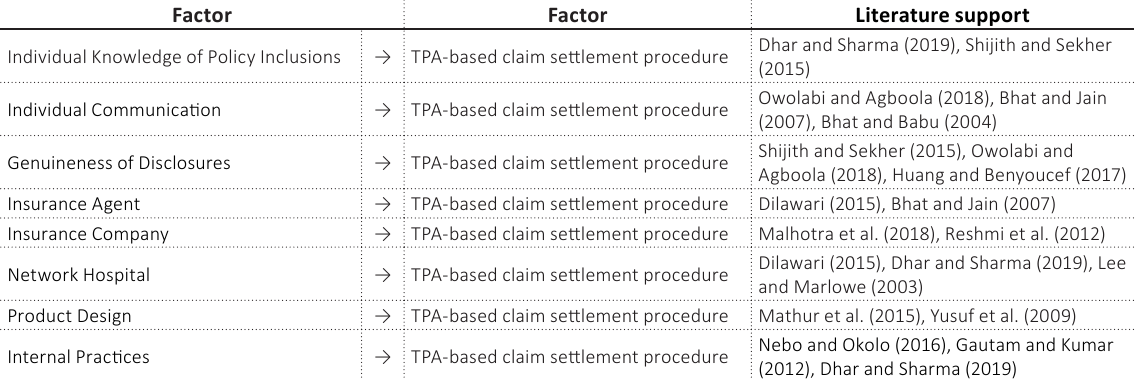
Table 8. Literary support for model Factor Factor Literature